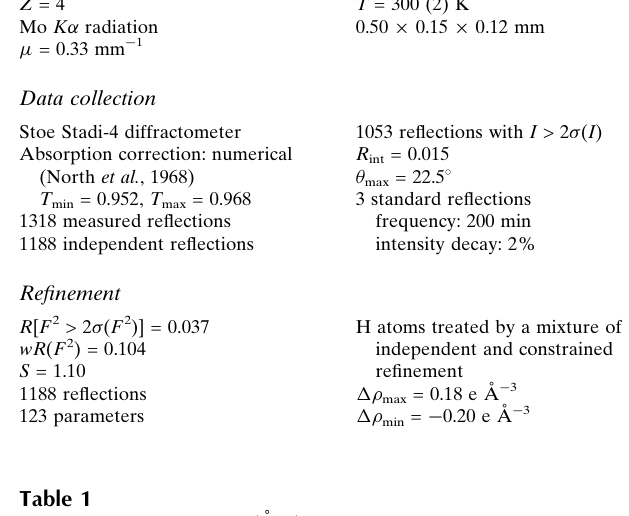
Hydrogen-bond geometry (A˚ , (cid:2)